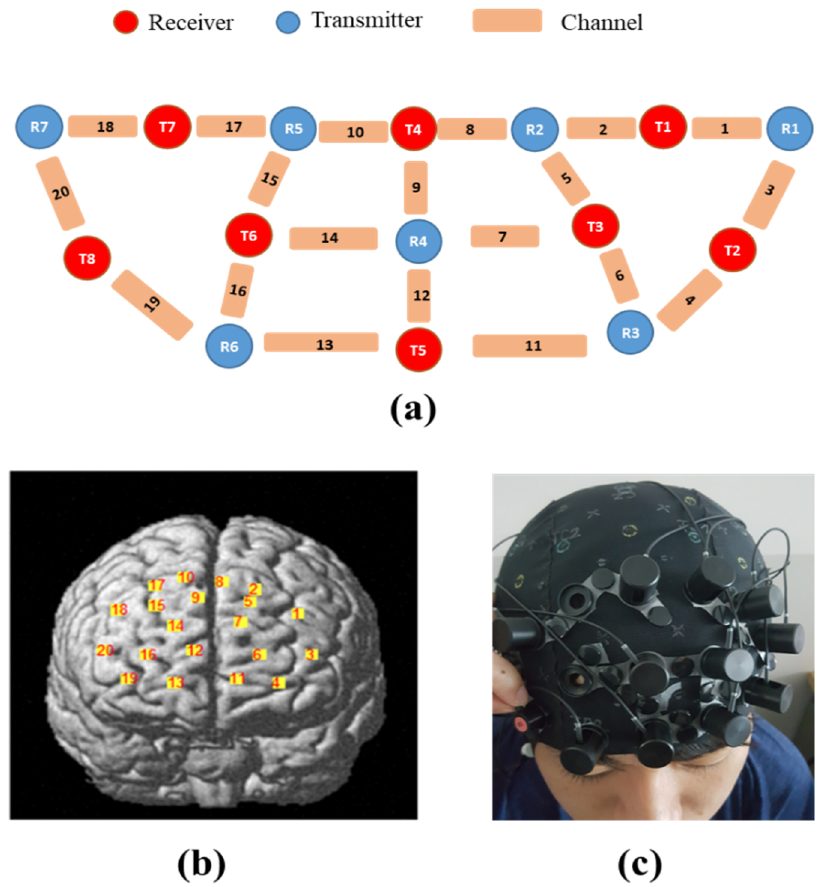
Figure 3. fNIRS system: ( a ) optodes structure, ( b ) channel locations, and ( c ) cap, and optodes.